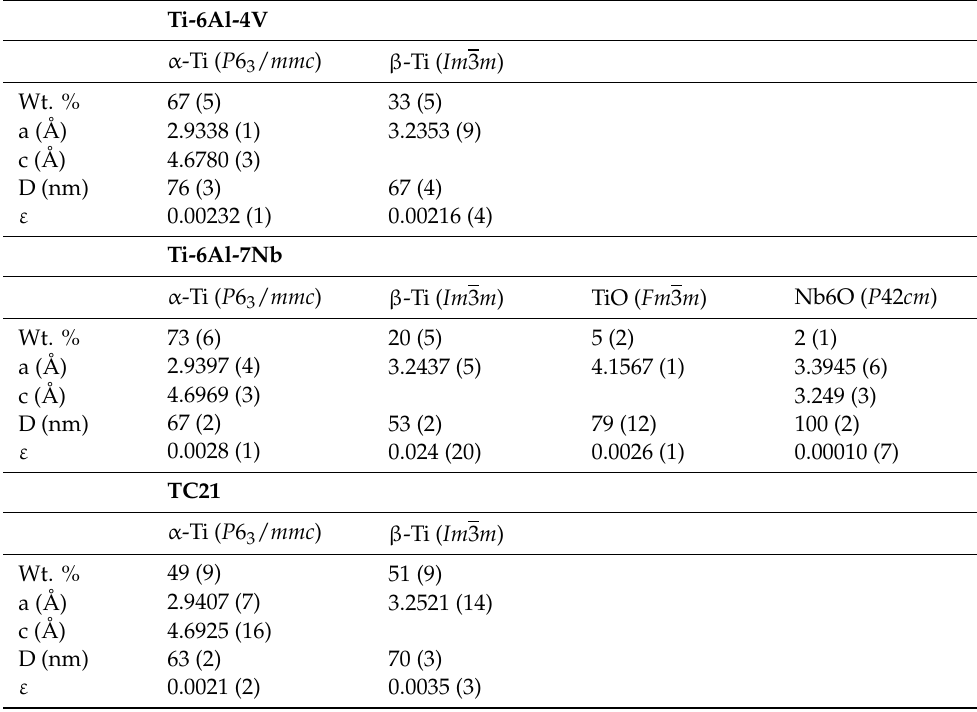
Table 6. The structural and microstructural parameters of the three alloys obtained by the Rietveld adjustment of the XRD patterns. Wt. % is the weight percentage of each phase, a and c are the cell parameters of the crystal lattice, D is the average crystallite-size and ε is the lattice